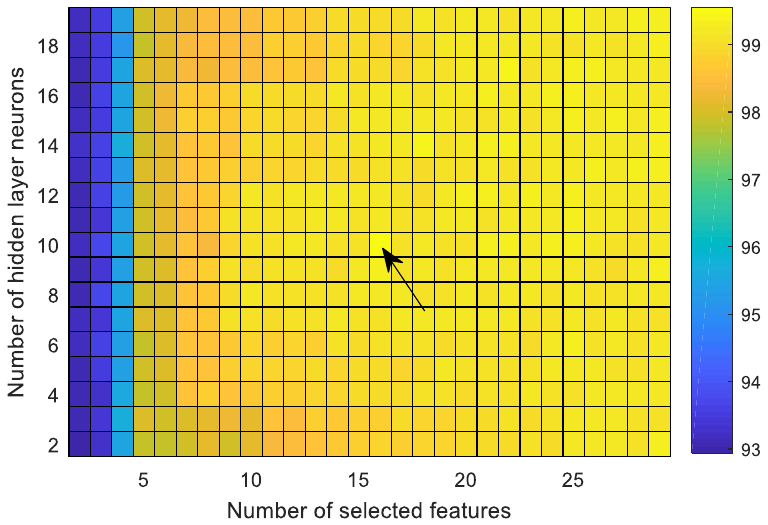
Figure 8. Average performance over nine cases as a function of the number of selected features (using GED) and number of neurons used in the hidden layer of FfNN. The maximum average accuracy is achieved with 18 selected features and 10 hidden neurons.